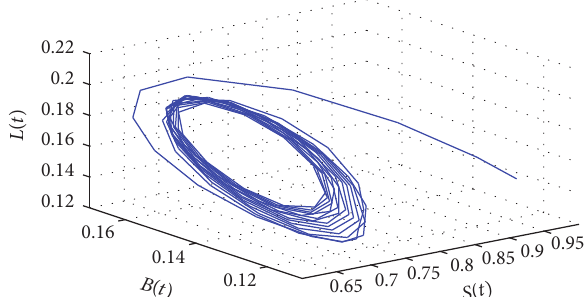
Figure 4: The phase plot of the states 𝑆 ∗ , 𝐿 ∗ , and 𝐵 ∗ when 𝜏 = 0.92, 0.155, 0.112 32.8965 > 𝜏 0 with initial value “